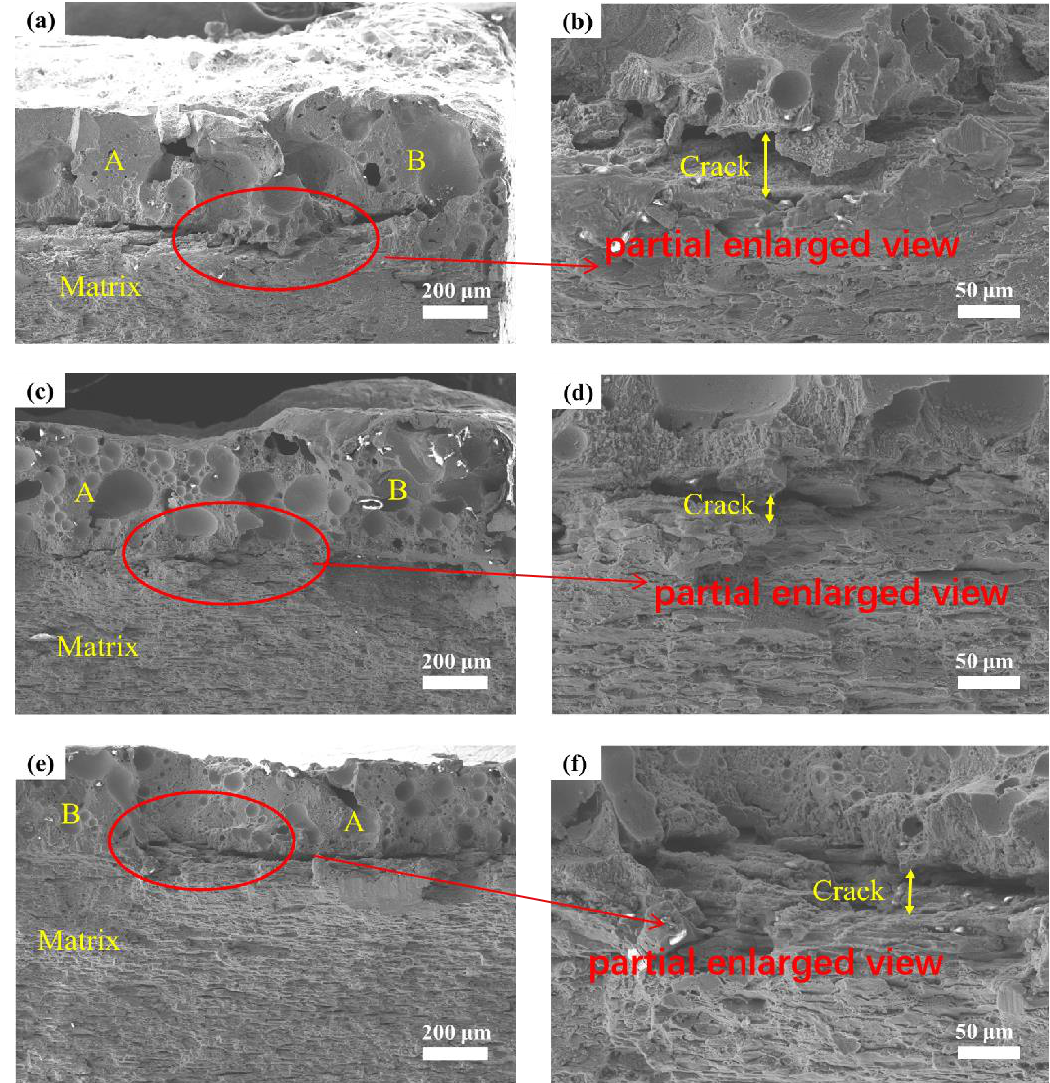
Figure 12. The fracture surfaces at the junction of regions A and B ( a , c , e ), and their partial enlarged view ( b , d , f ).